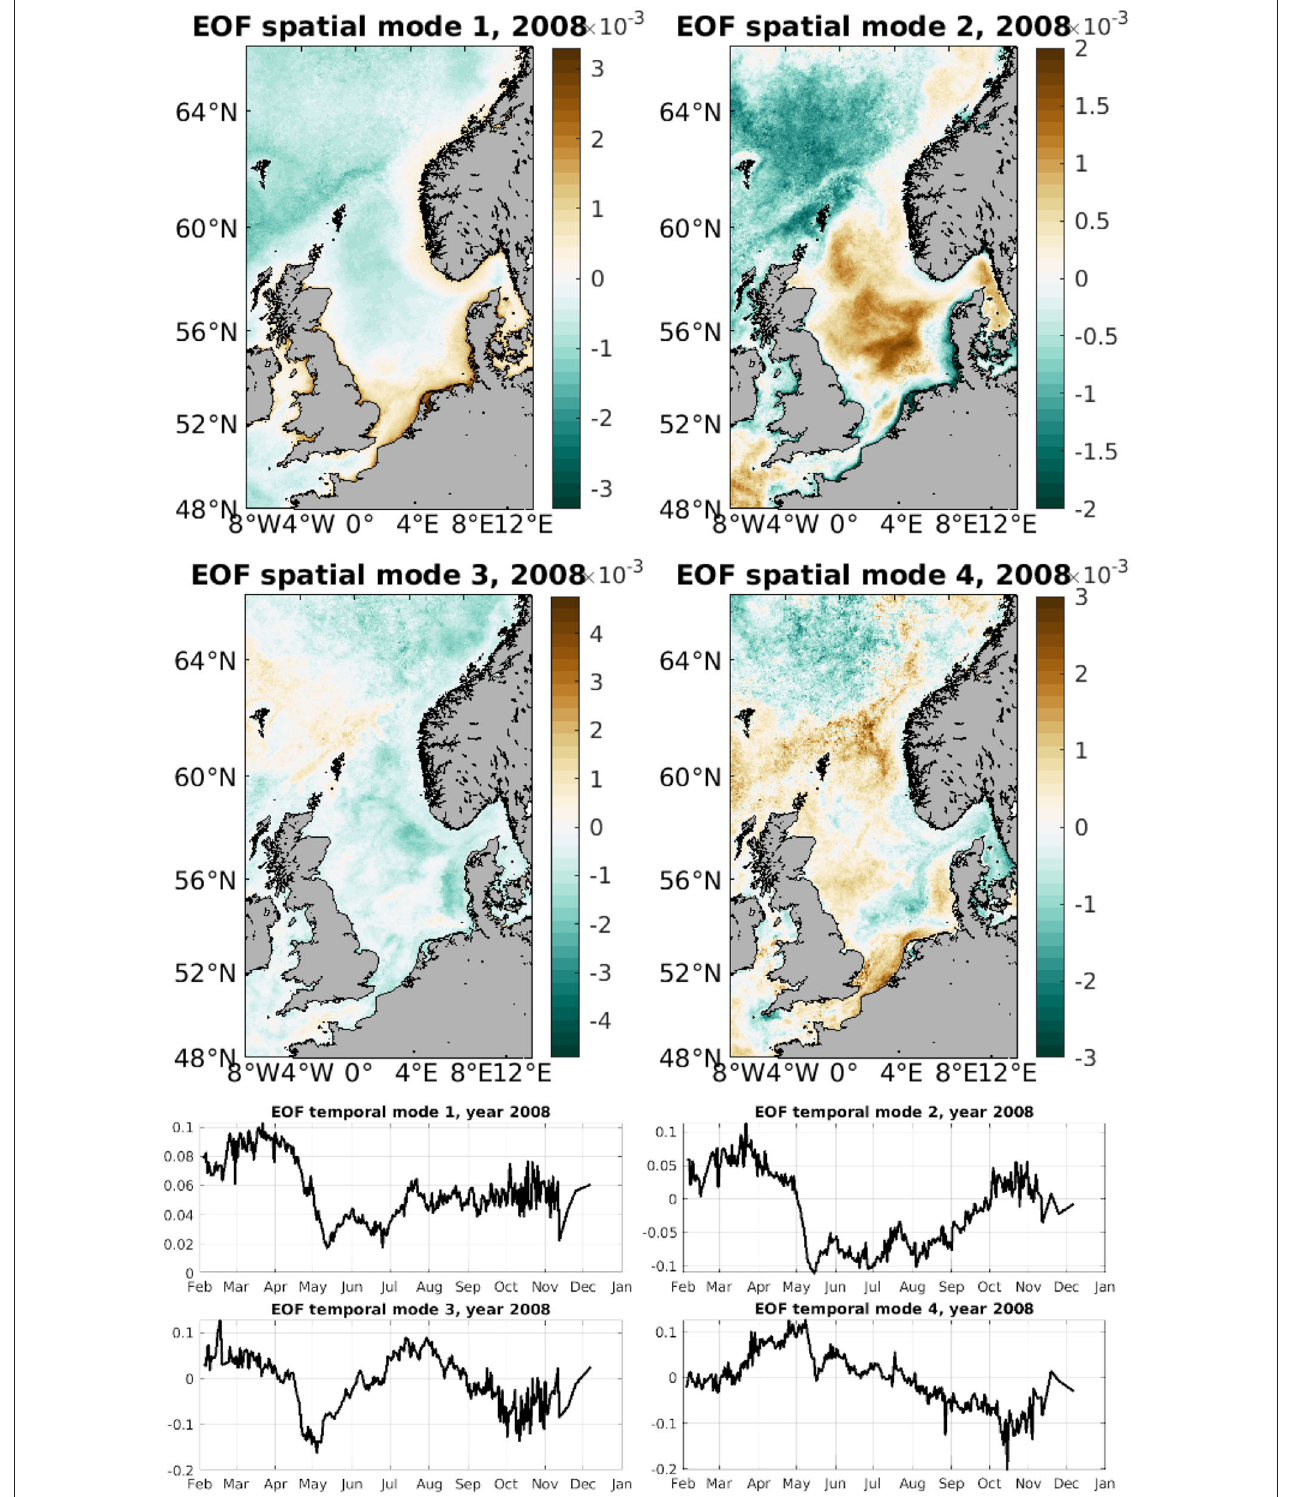
FIGURE 6 | First four spatial CHL EOF modes for 2008 ( top two rows) and first four temporal CHL EOF modes for 2008 ( bottom two rows).